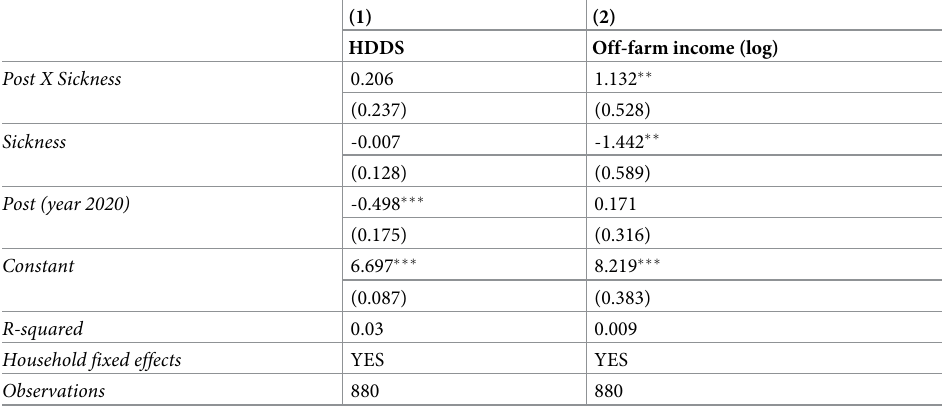
Table 8. Regression results for COVID-19 effects on dietary diversity and off-farm